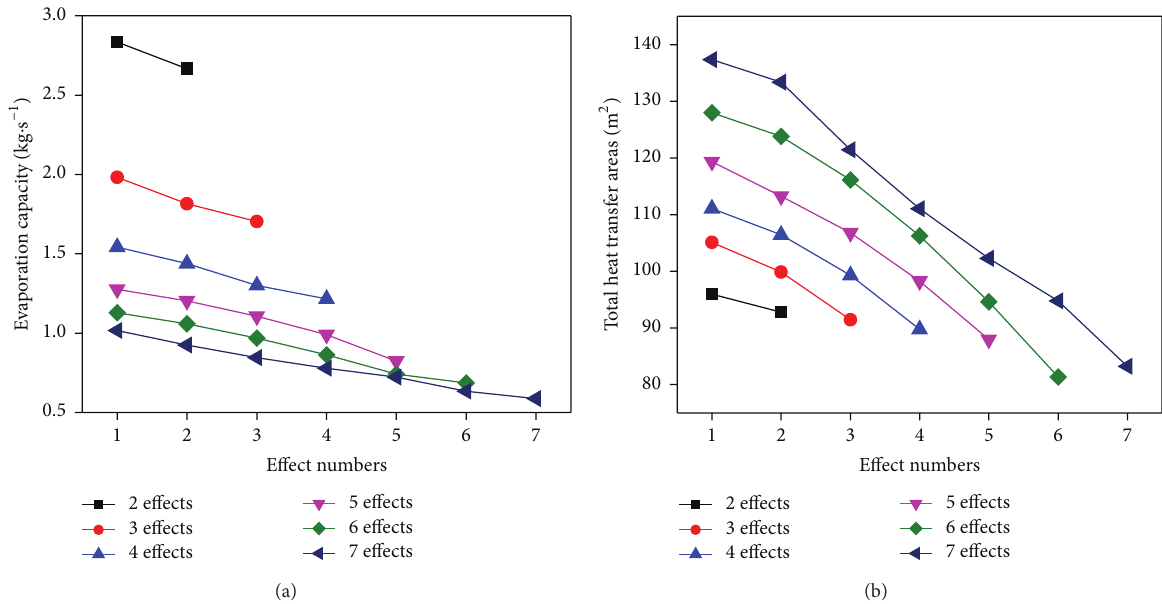
Figure 1: The influence of effect numbers on the evaporation capacity and heat transfer areas of each effect in MED.